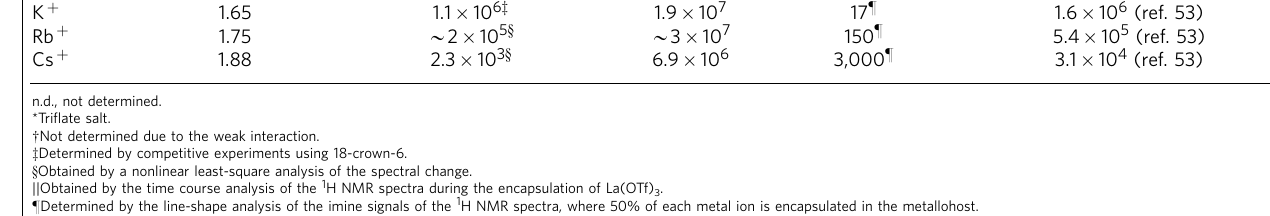
Table 1 | Association constants and kinetic data for the complexation between 1 2 þ or 18-crown-6 and guest cations. Kinetic data Association constant of 18-crown-6 Guest * Ionic radius (Å) 52 Association constant K a (M (cid:3) 1 ) K a (M (cid:3) 1 ) k in (M (cid:3) 1 s (cid:3) 1 ) k out (s (cid:3) 1